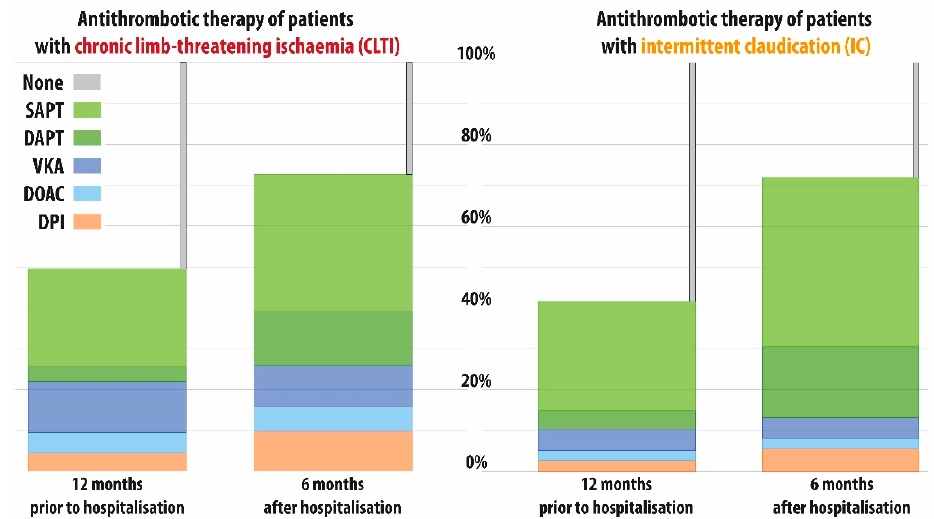
Figure 2. Proportions of patients with antithrombotic therapy 1 year before and 6 months after index stay for symptomatic peripheral arterial occlusive disease (PAOD); SAPT: Single antiplatelet therapy, DAPT: Dual antiplatelet therapy, VKA: Vitamin K antagonists, DOAC: Direct oral anticoagu- lation, DPI: Dual pathway inhibition, CLTI: Chronic limb-threatening ischaemia, IC: Intermittent claudication.